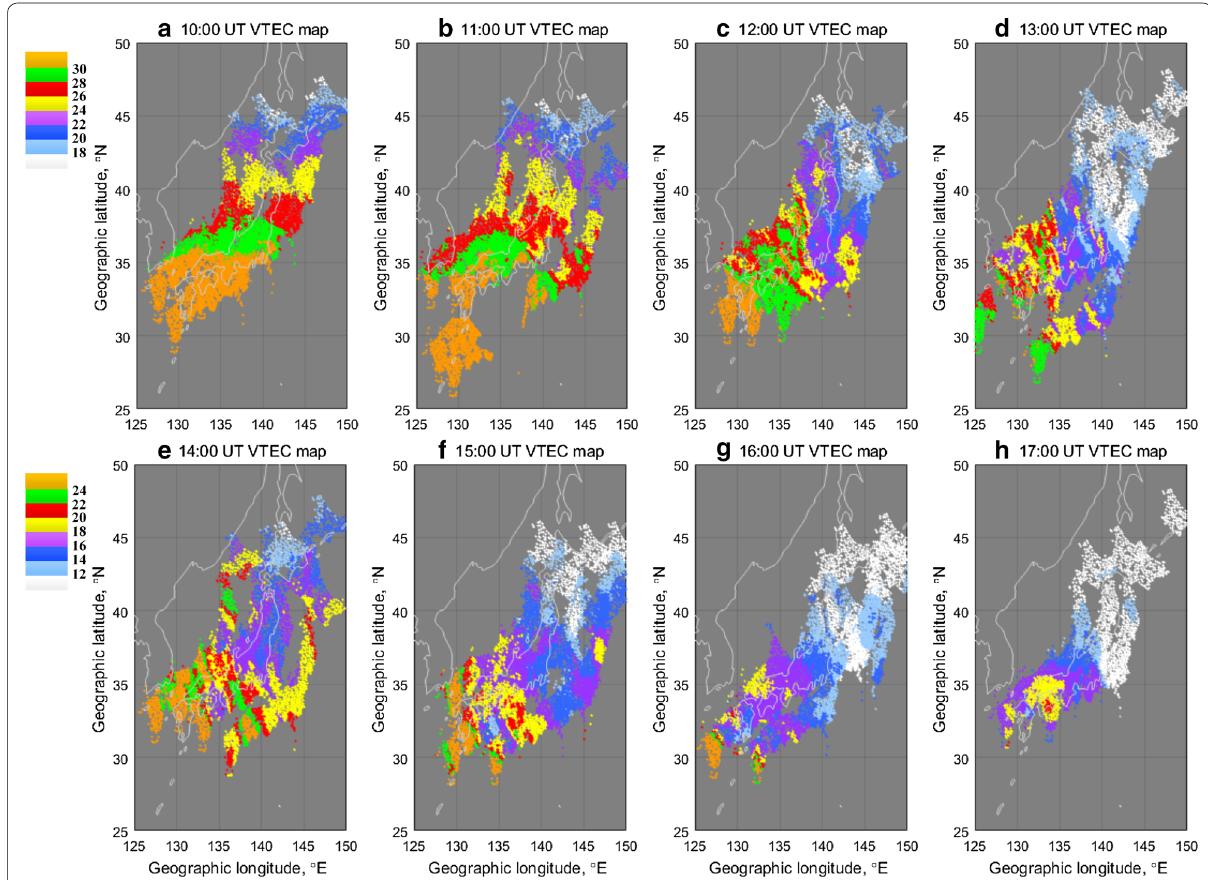
Fig. 4 VTEC maps from 10:00 UT (19:00 JST) to 17:00 UT (03:00 JST) of 11 July 2014. Unit of the legend is TECU. Note that the VTEC legends have been reduced by 6 TECU after 14:00 UT as the background VTEC